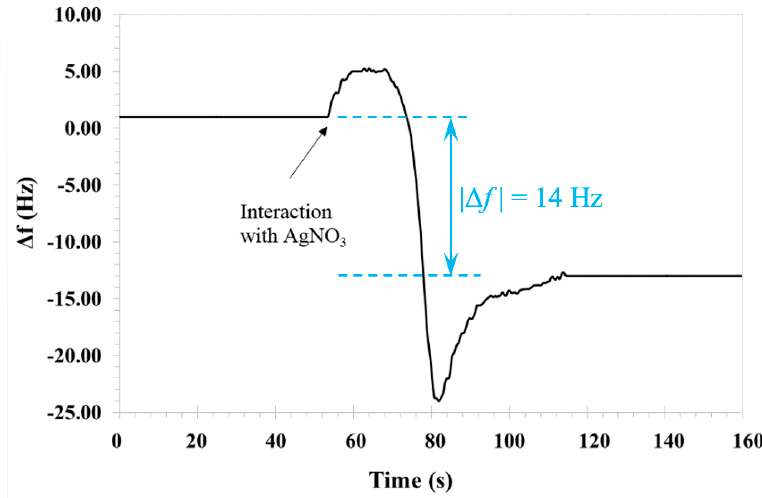
Figure 1. Quartz crystal microbalance (QCM) result: variation of the crystal frequency ( ∆ f ) after interaction of the cellulose film (grafted with 1,6-hexanediamine) with AgNO 3 monitored as a function of the time.